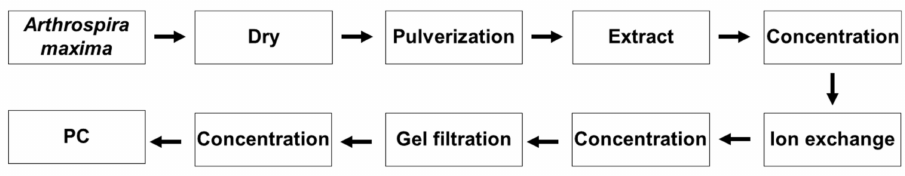
Figure 3. Procedure used to extract phycocyanin (PC) and obtain analytical grade PC.